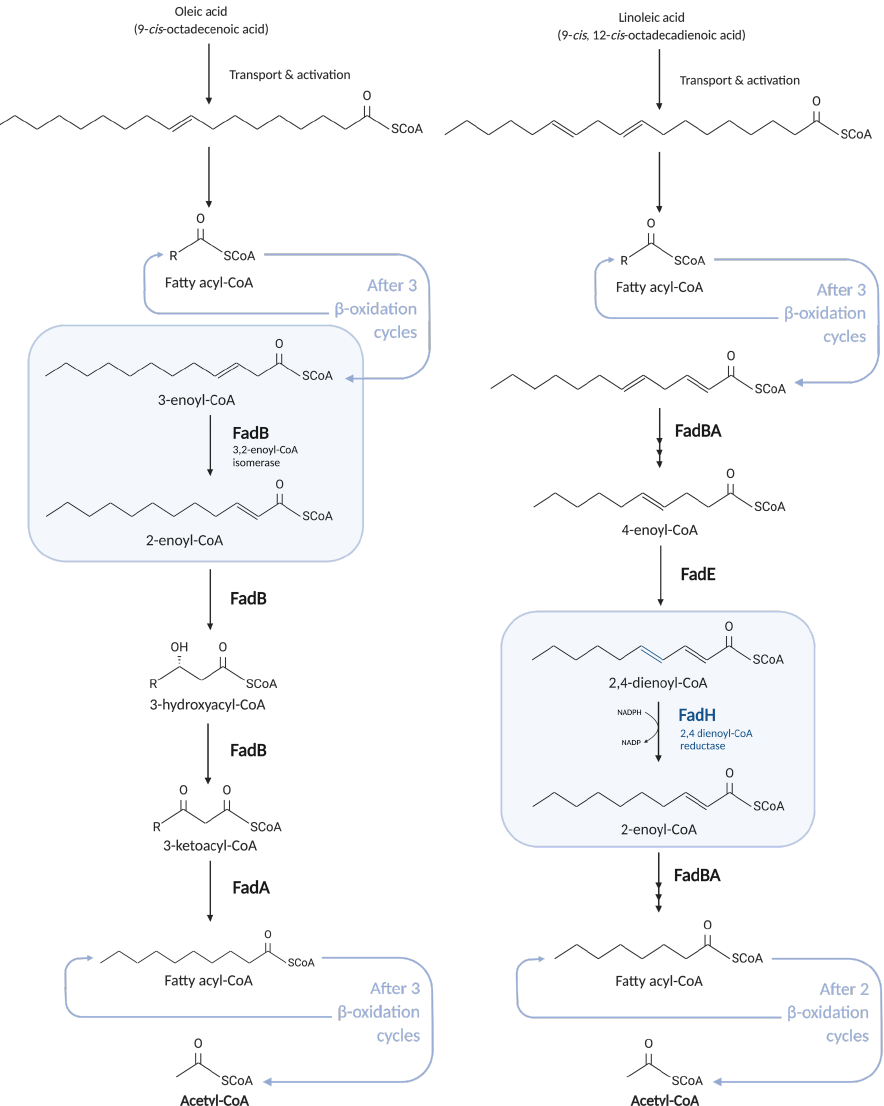
Figure 5. Degradation of unsaturated fatty acids (UFAs). UFA with a double bond extending from odd-numbered carbons (e.g., oleic acid, on the left) can be degraded thanks to the additional 3,2-enoyl-CoA isomerase activity of FadB (in the blue box on the left). UFA with double bonds extending from even-numbered carbons (e.g., linoleic acid, on the right) requires the auxiliary enzyme FadH carrying out a 2,4 dienoyl-CoA reductase activity (in the blue box on the right).